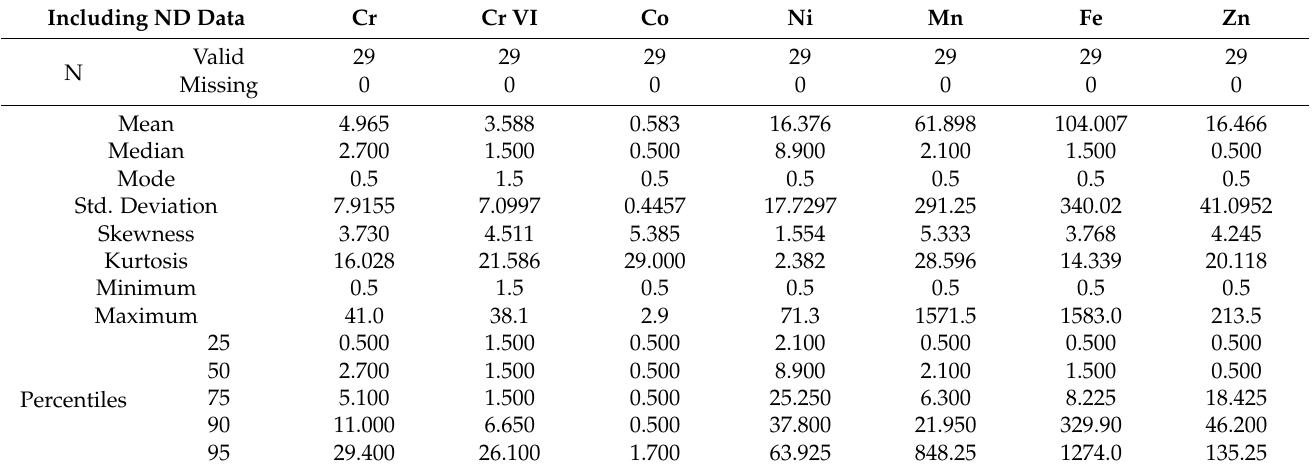
Table 2. Descriptive statistics of the representative PTE values (in µ g/L) for each